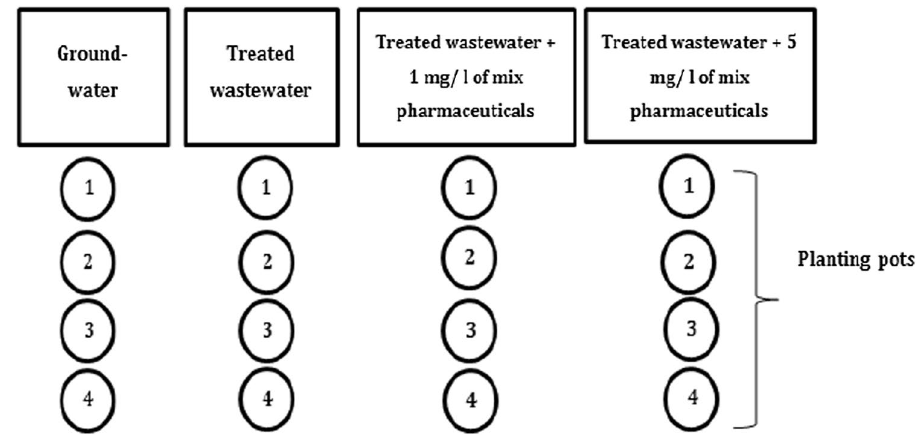
Fig. 1 The layout of the field